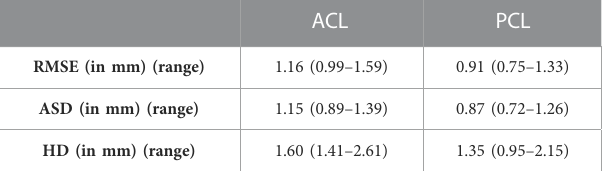
TABLE 6 Median RMSE, ASD and HD with range for the ACL and PCL course.